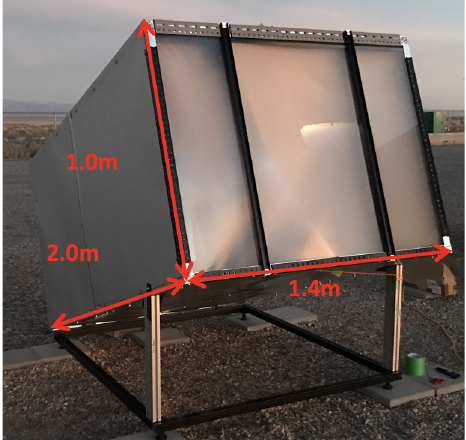
Figure 1. The exterior of CRAFFT prototype detector deployed at TA site in Utah, USA.